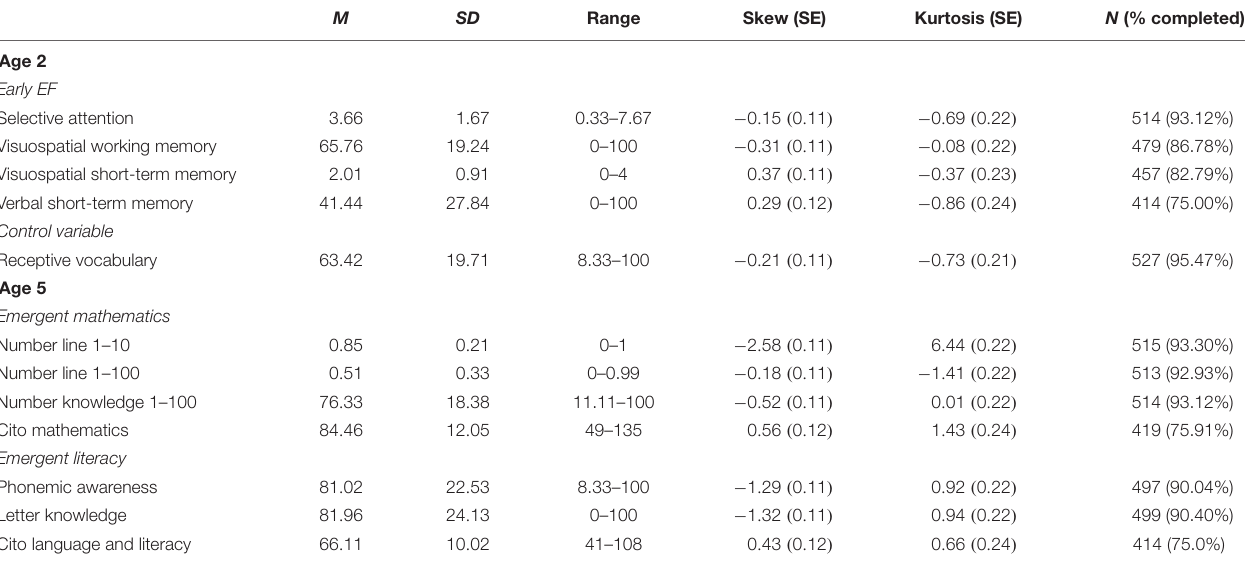
TABLE 1 | Descriptive statistics for all tasks.